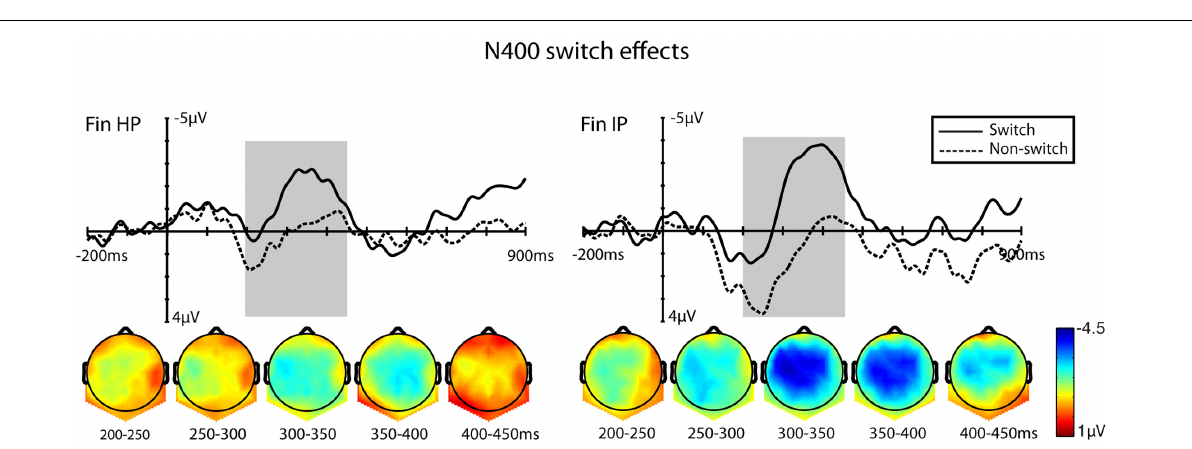
FIGURE 3 | Grand-average waveforms taken from a ROI consisting of a set of nine fronto-central electrodes to represent the switching effects. Switched stimuli and non-switched stimuli are taken together and plotted for the two L2 groups. Accompanying scalp maps were obtained every consecutive 50 ms from 200 ms until 450 ms and reflect the averaged values of difference waves (language-switched minus non-switched). The 200 ms baseline is plotted, and time 0 marks the onset of the target